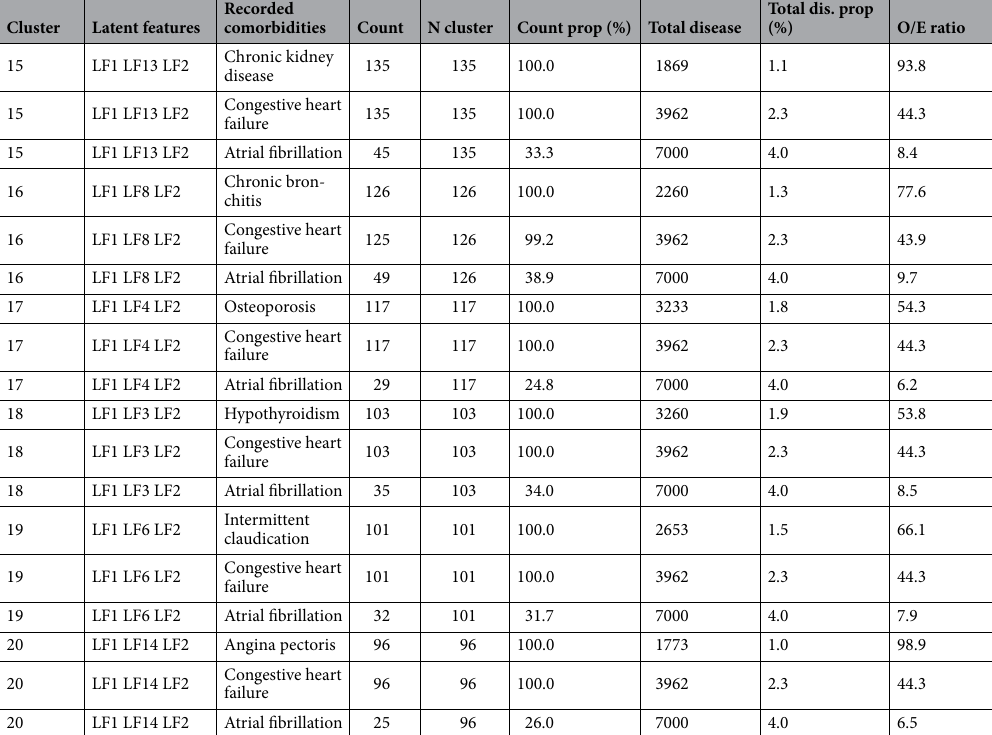
Table 2. Description of the three most prevalent conditions for the first 20 clusters. Count, numbers of patients with that disease in that cluster; N cluster, total number of individuals within that cluster; Count prop, proportion of patients who have that disease within a cluster; Total disease, overall number of patients with that disease; Total dis. Prop, overall proportion with that disease; O/E ratio, observed to expected ratio. All identified comorbidities were identified via read codes, as recorded anytime on or before the index date, defined as the first prescribed non-insulin antidiabetic drug